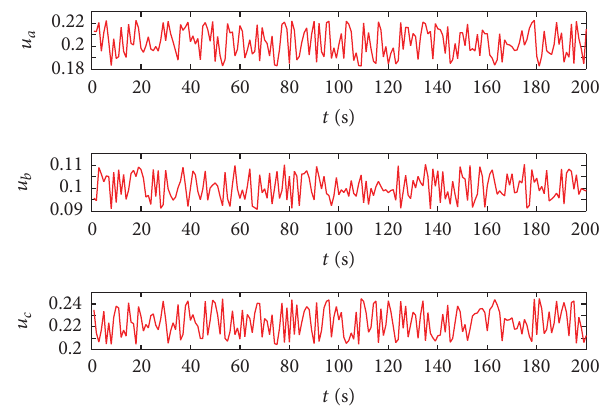
Figure 8: Evolution profiles of manipulated variables 𝑢 𝑎 , 𝑢 𝑏 , and 𝑢 𝑐 with perturbed signals.